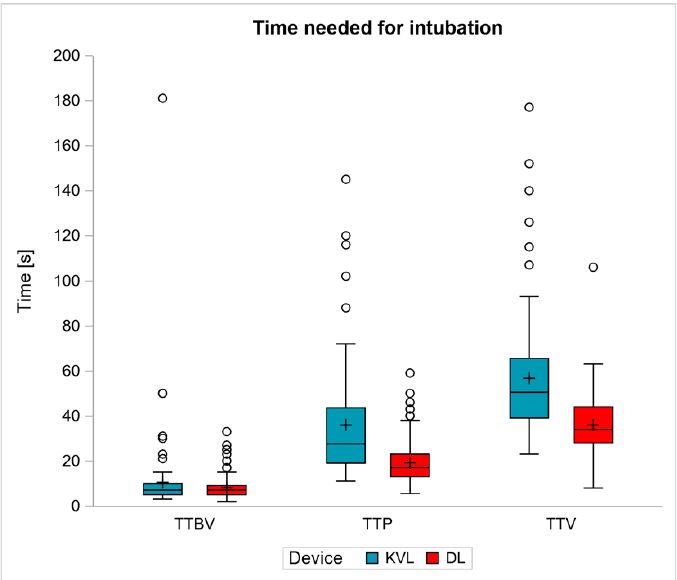
Figure 4. Time needed for the intubation steps in comparison of the King Vision™ Paediatric aBlade™ video laryngoscope (KVL) and direct laryngoscopy with the Macintosh blade (DL) in seconds [s]. TTBV: time to best view, TTP: time to placement of the tracheal tube, TTV: time to ventilation.